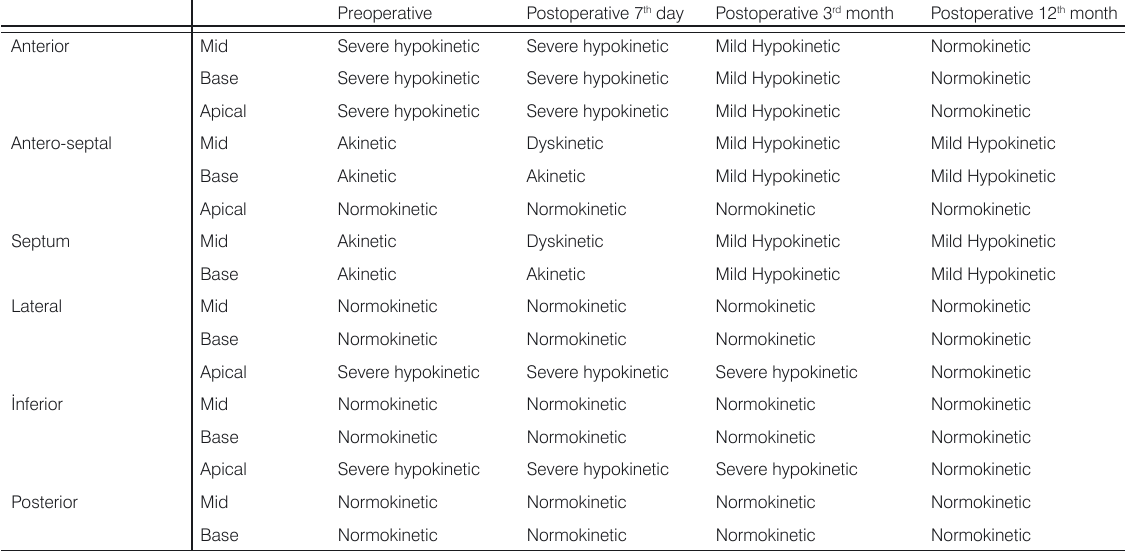
Table 2. Preoperative and postoperative echocardiographic data demonstrating wall motion status for 16 segments of the left ventricle.